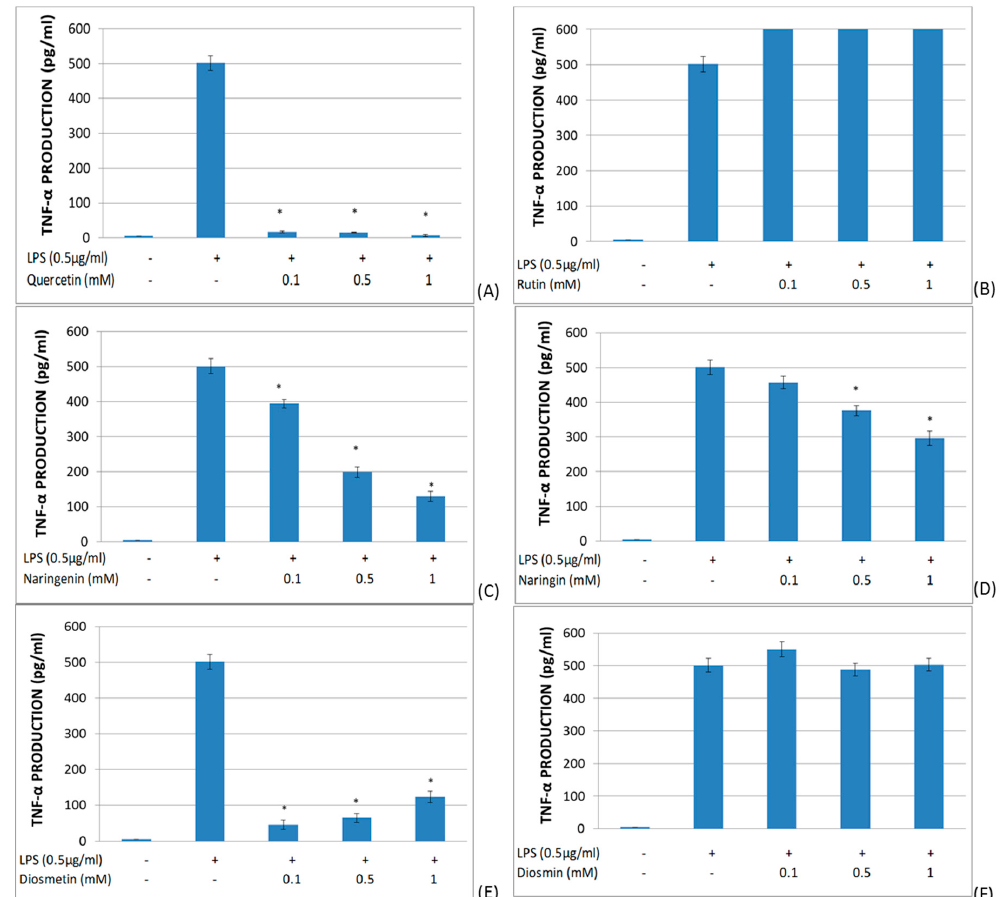
Figure 3. Effects of different flavonoids on the production of TNF- α in LPS-stimulated (0.5 μ g/mL) whole blood after 6 h of culture. The different panels show the results of the effects of quercetin ( A ), rutin ( B ), naringenin ( C ), naringin ( D ), diosmetin ( E ), and diosmin ( F ). All data are expressed as the mean (top segment of the rectangles) ± SEM (vertical segment) of thirty independent experiments. * p < 0.05: significantly different when compared to the LPS control.